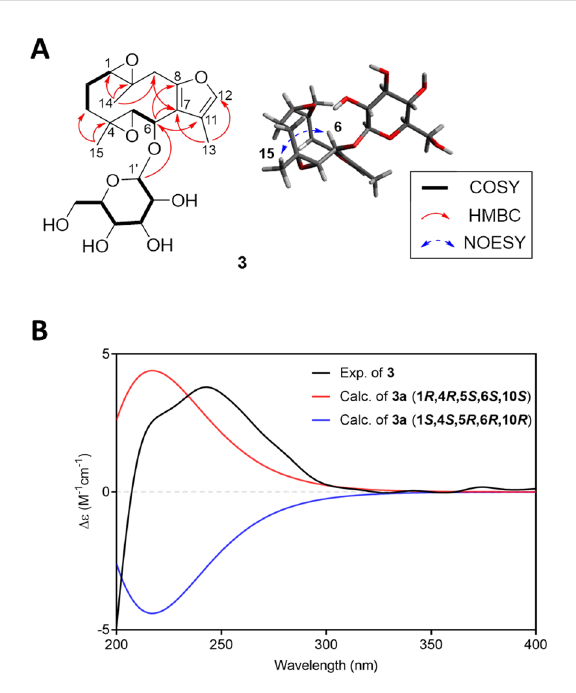
Figure 4: Structure elucidation of 3 . (A) Key COSY, HMBC, and NOE correlations of 3 . (B) Comparison of calculated and experimental ECD spectra of 3